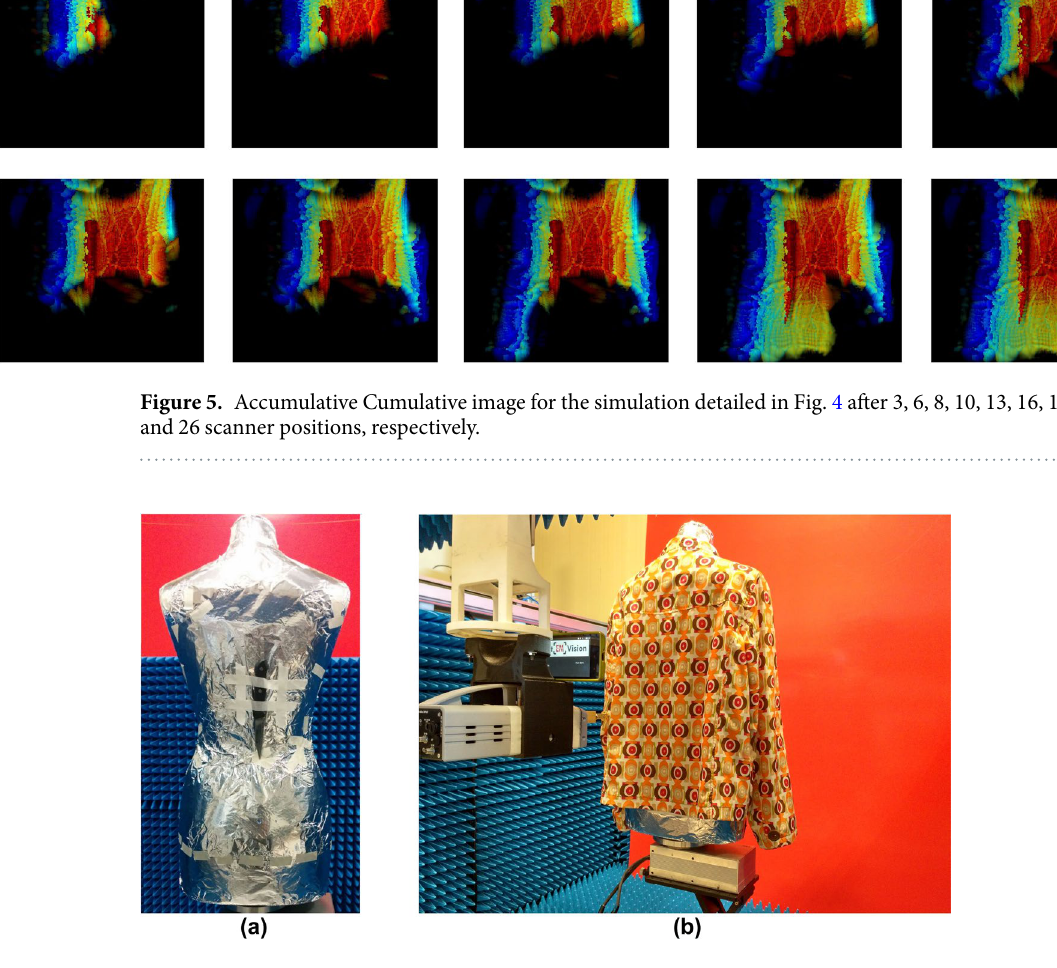
Figure 6. Measurement setup comprising a mannequin with an attached knife on a rotary platform, an optical camera and the mm-wave sensor used to implement the scanner aperture installed on the three-axes linear stage: ( a ) without coat; ( b ) with